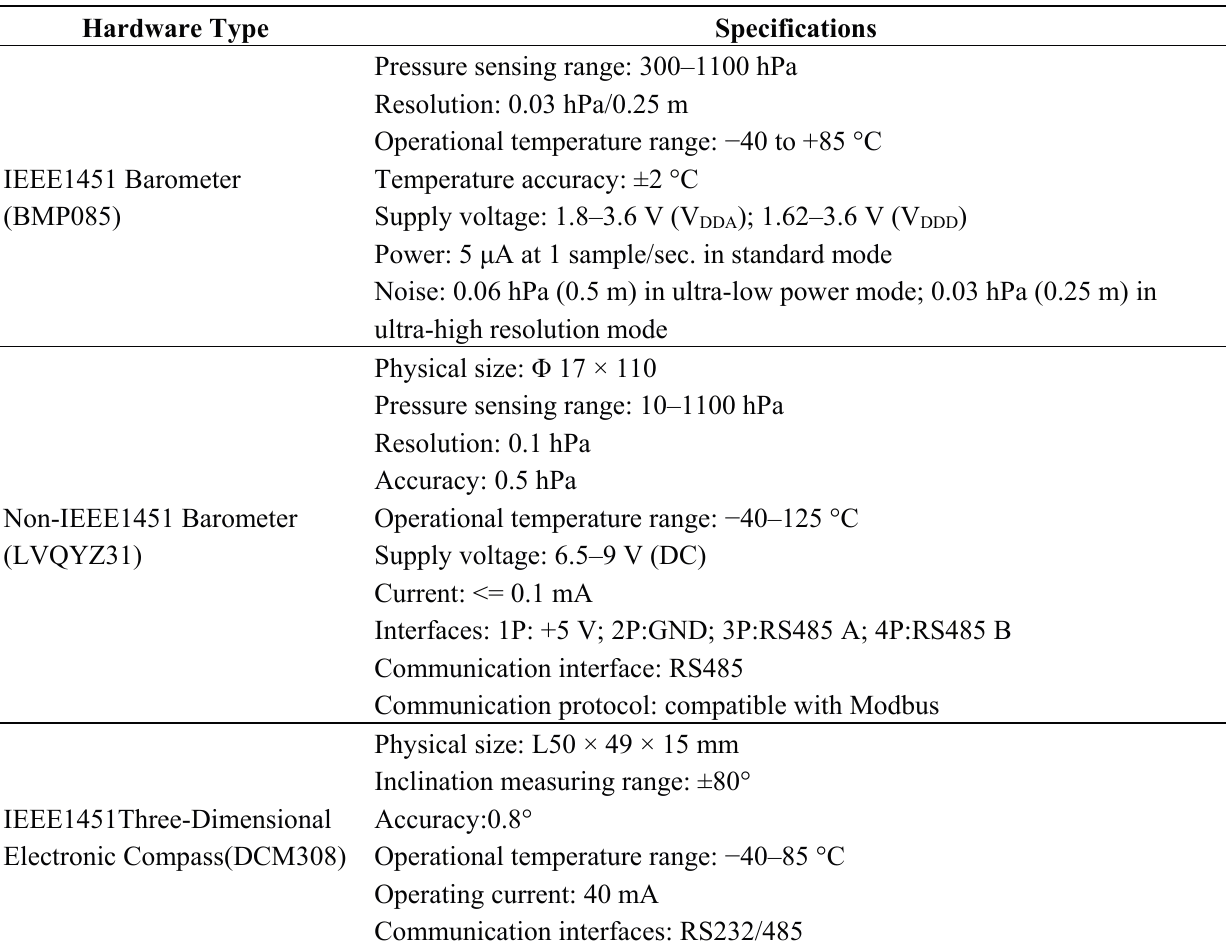
Table 5. Specifications of three experimental